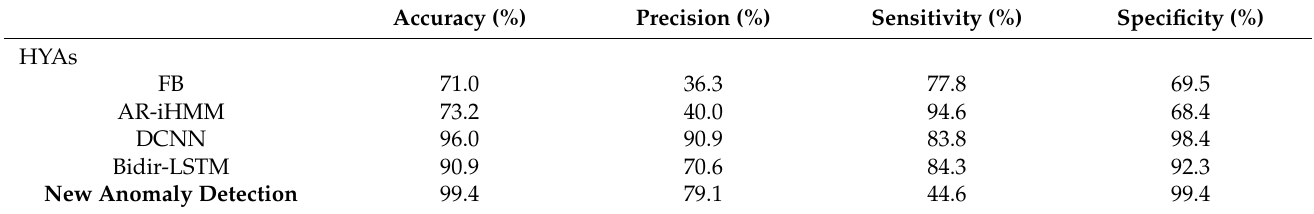
Table 2. Comparing a new anomaly detection algorithm with prior methods. The algorithm’s performance in gait detection (values in parentheses indicate the STD between the different valida- tion